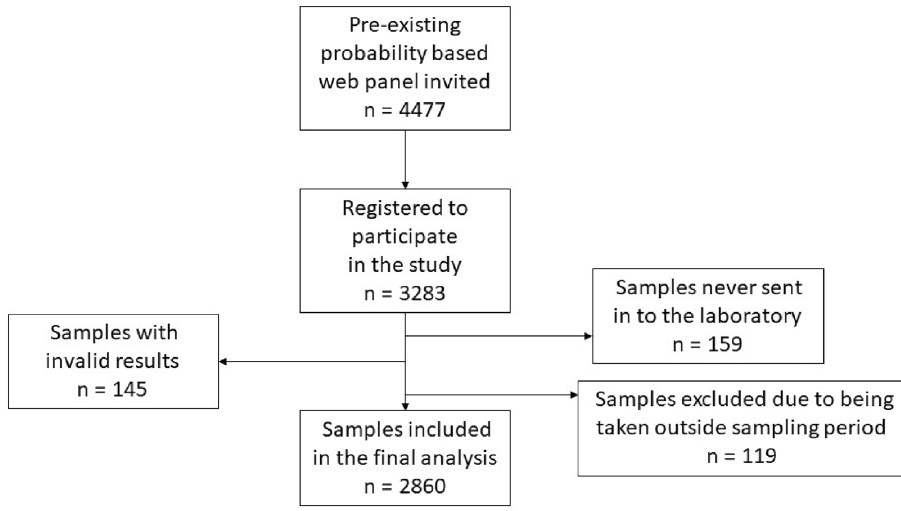
Figure 1. Inclusion of study participants.